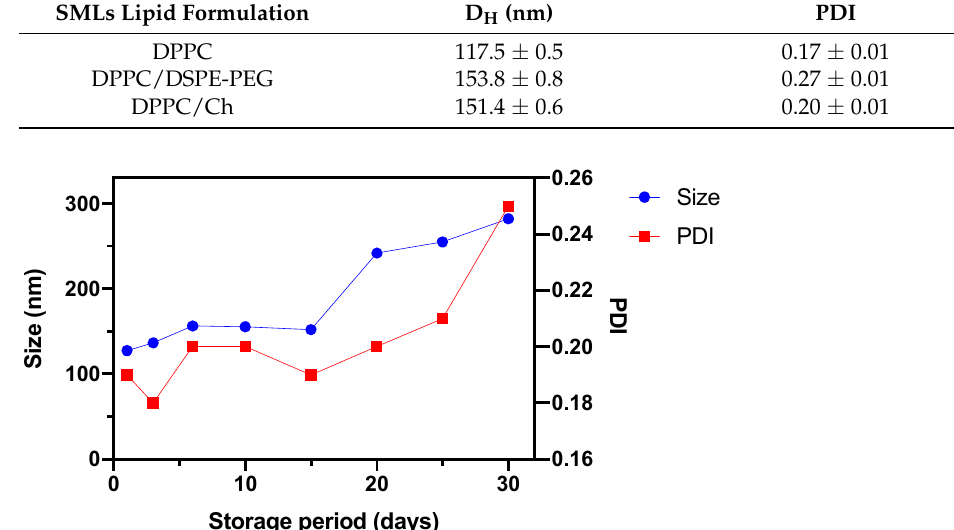
Figure 9. Hydrodynamic diameter and polydispersity (PDI) evolution of an aqueous solution of DPPC-based SMLs during storage at 4 °C for 30 days.